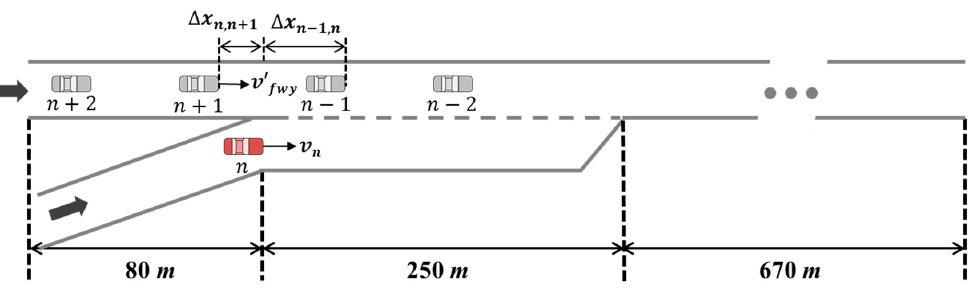
Figure 15. Simulation network configurations.